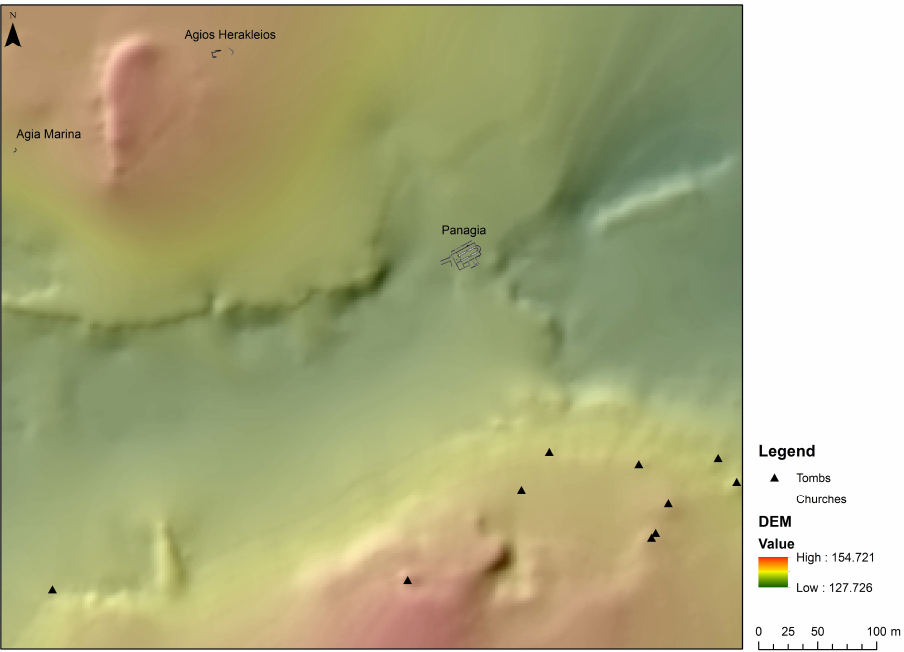
Figure 16. Group of rock-cut tombs at the south edge of Kophinou-Panagia (Map by Niki